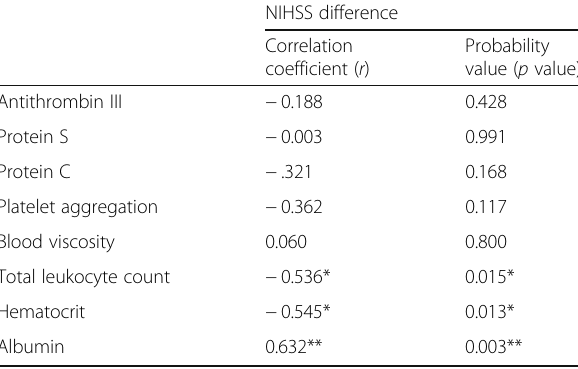
Table 6 Correlation between stroke outcome and results